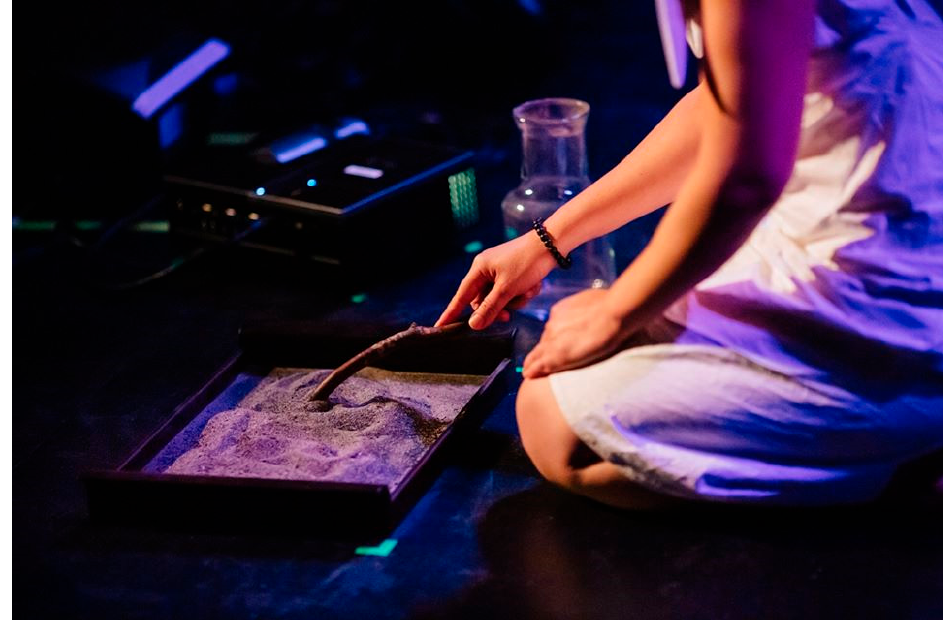
Figure 14. Shin Yu Pai’s performance “Embarkation,” courtesy of Forterra.